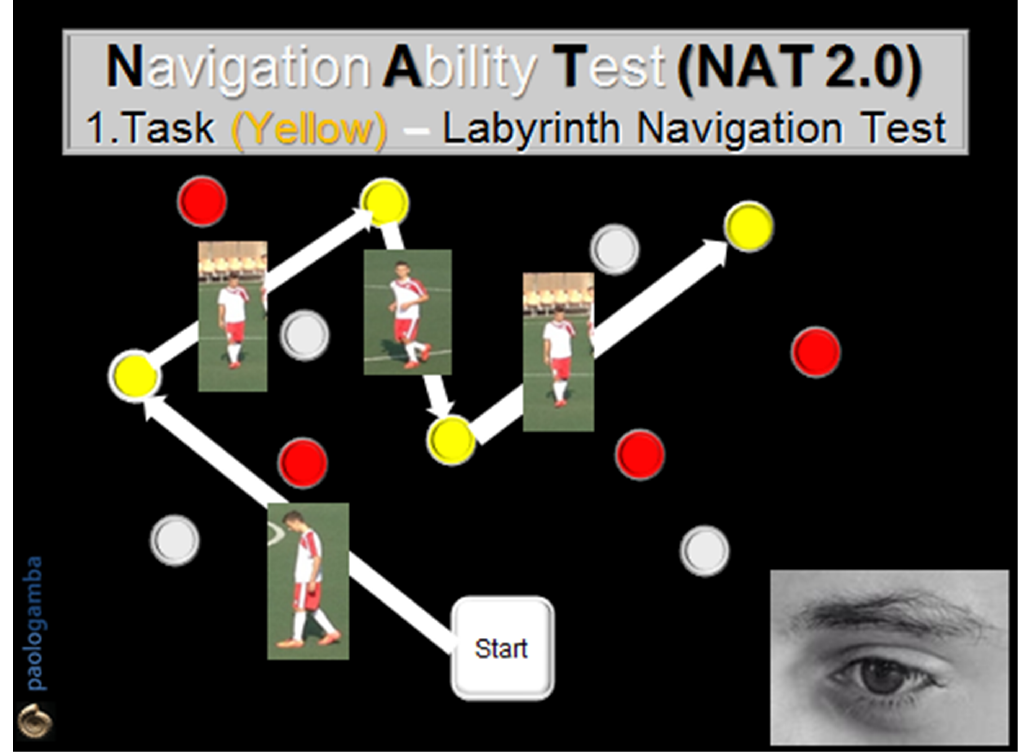
Figure 1. Navigation Ability Test (NAT 2.0). Task 1 (yellow): the subject visually memorizes and then walks with closed eyes along a path drawn by some yellow numbered obstacles located on the ground in front of him/her. The task is performed twice, in both directions, reaching one obstacle after another, according to the numerical order previously visually detected.